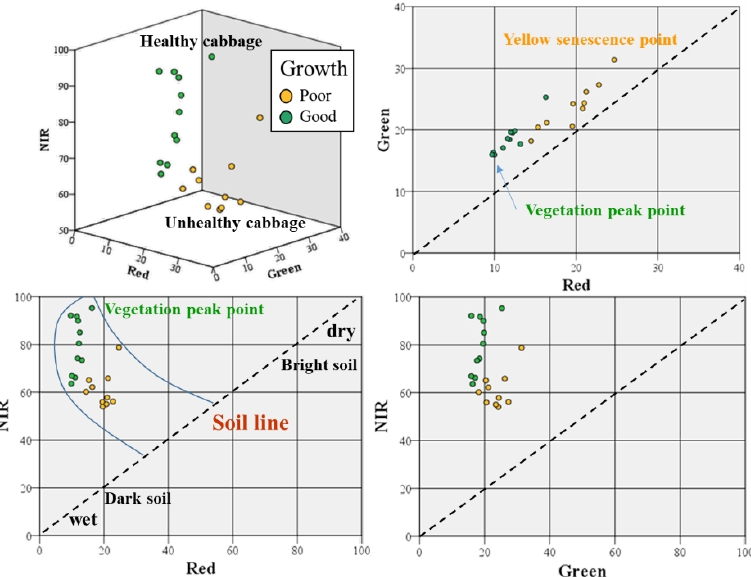
Figure 10. Three-dimensional distribution of the green, red, and near-infrared wavelengths of healthy and unhealthy cabbages and the correlation of each band identified by the spectroradiometer. As a result of comparing the UAV-mounted-sensor and field-portable spectroradiometer spectrum information, the red sensor values showed the highest correlation in the three bands; the NIR band showed an intermediate correlation, and the green wavelength showed the lowest correlation (Figure 11). These results show that it is useful to use red and near-infrared wavelengths along with the vegetation index. Therefore, this study focused on the NDVI, which expressed both wavelengths well.